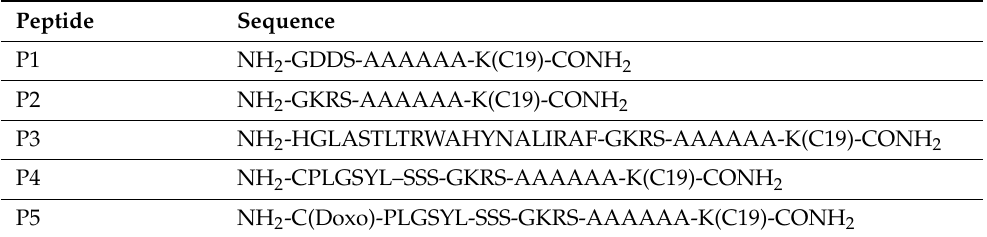
Table 1. Sequences of peptides P1–P5 forming the nanofiber. Peptide